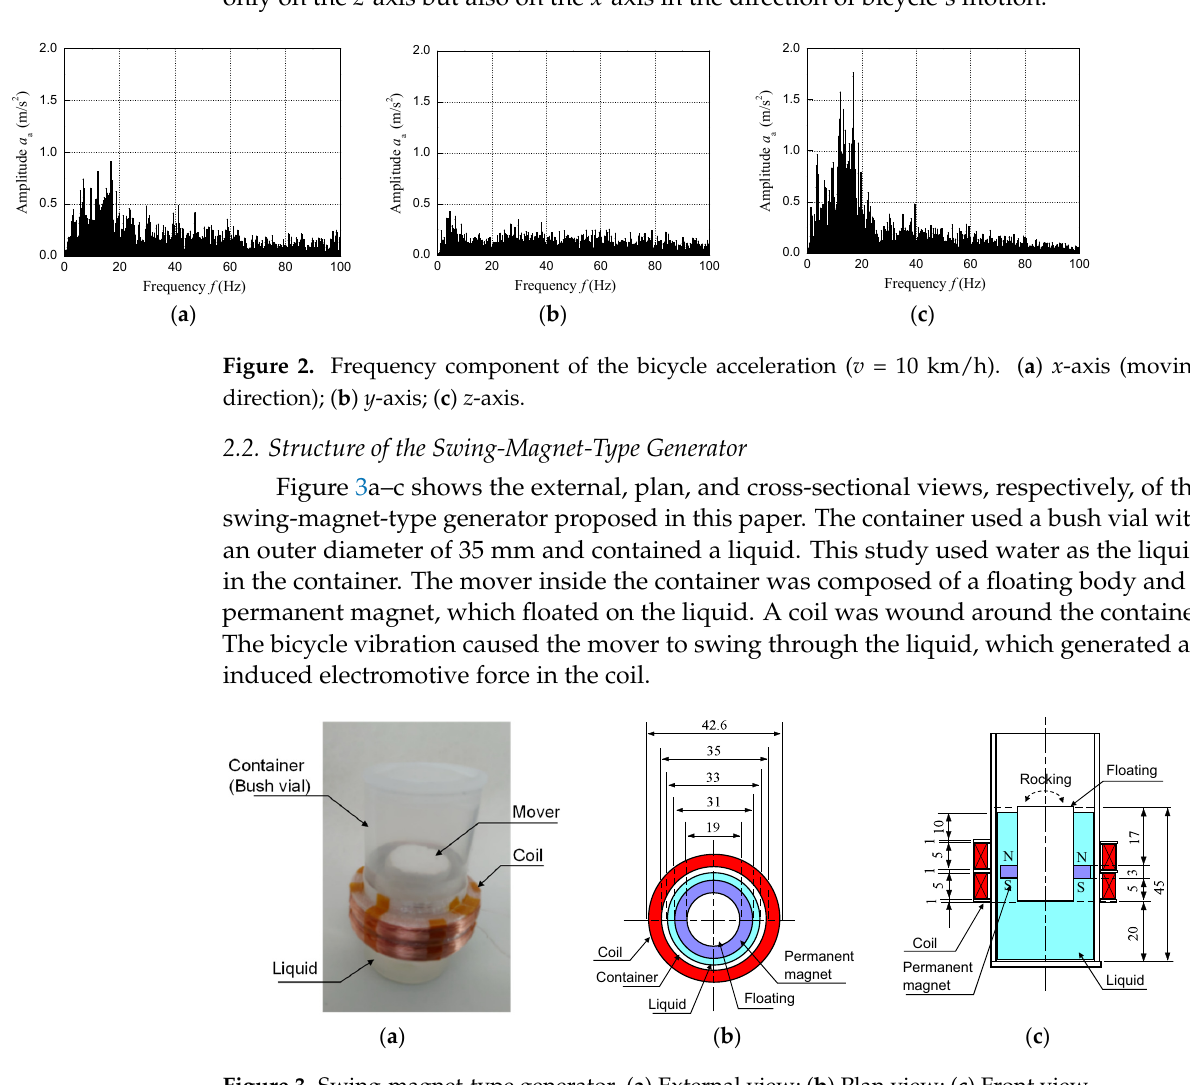
Figure 3. Swing-magnet-type generator. ( a ) External view; ( b ) Plan view; ( c ) Front